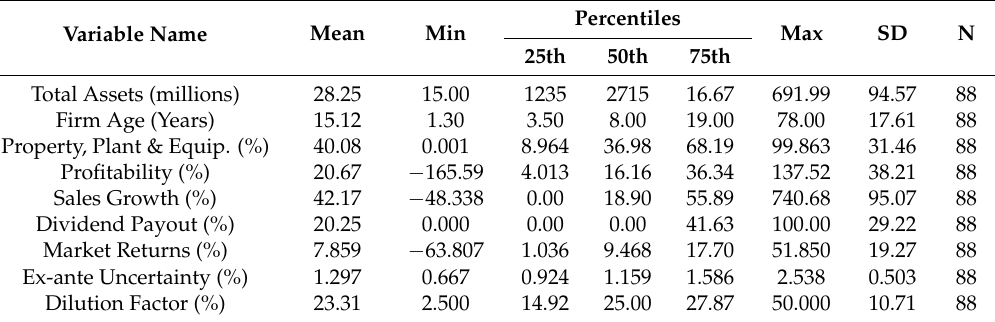
Table 3. Descriptive Statistics.